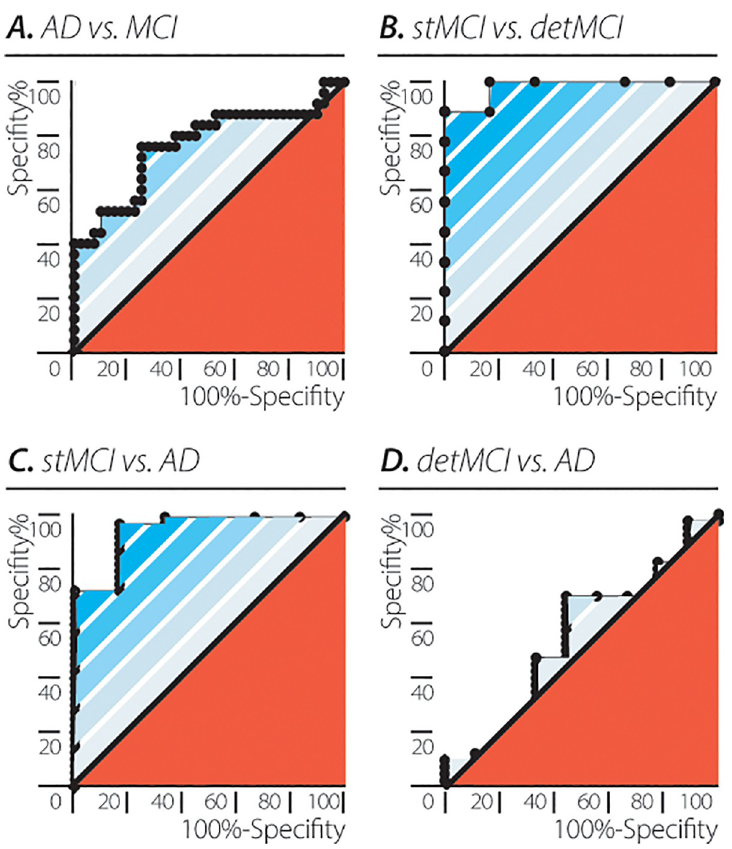
Fig 6. Accuracy of differentiating between neurocognitive diseases using the EEG quantum potential mean and variability score (qpmvs). Accuracy depicted as receiver operating characteristic (ROC) curves for (A) AD vs. MCI (AUC = 0.7660 ± 0.06559, 95% CI: (0.6374–0.8946), p = 0.0003). (B) stbMCI vs. detMCI (AUC = 0.9815 ± 0.029, 95% CI: (0.9245–1.000), p = 0.0022). (C) stbMCI vs. AD (AUC = 0.950 ± 0.044, 95% CI: (0.8622–1.000), p = < 0.0004). (D) detMCI vs. AD (AUC = 0.533 ± 0.112, 95% CI: (0.3142–0.7524), p = 0.756).